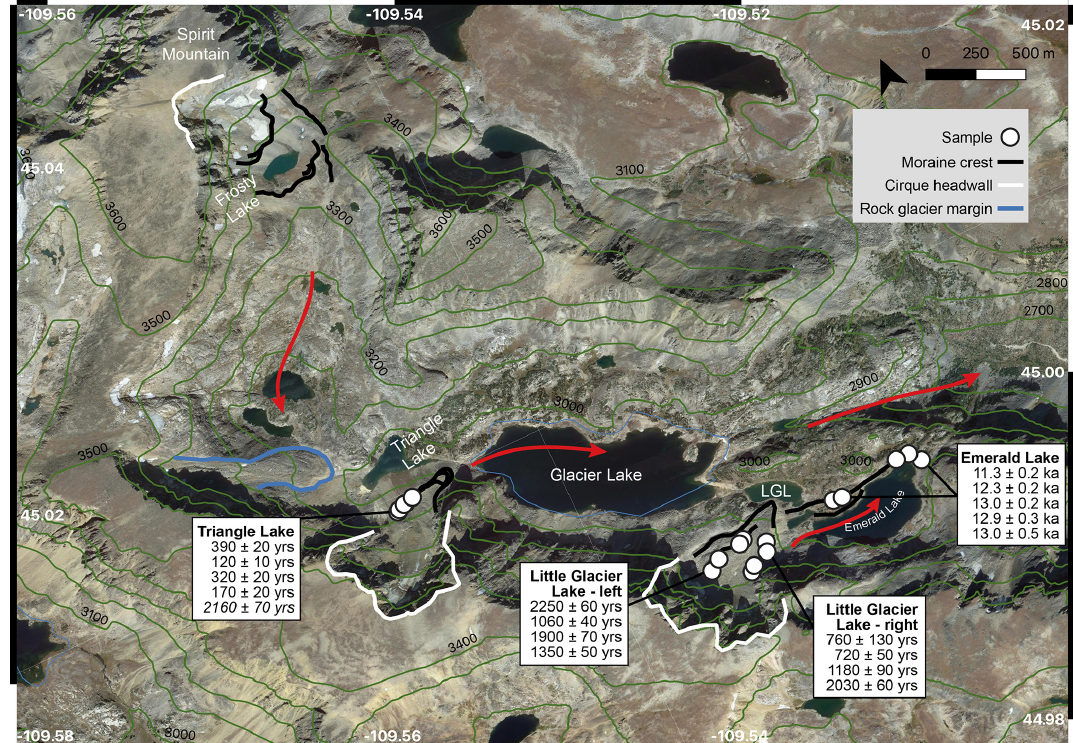
Figure 2. Glacier Lake Valley map highlighting the names of important locations discussed in the paper. White lines indicate the cirque headwalls. Solid black lines show the location of moraines. White circles indicate the locations of surface exposure samples with their ages contained in the respective boxes. Statistically identified outliers are italicized. LGL stands for Little Glacier Lake. Red arrows indicate generalized ice flow direction. Elevation data are from the U.S. Geological Survey 3D Elevation Program (U.S. Geological Survey,